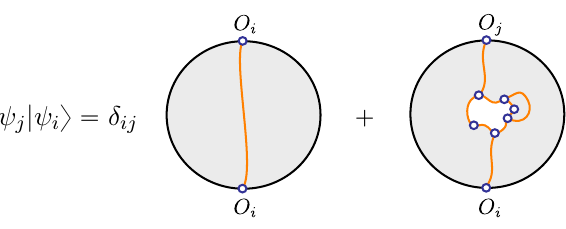
Figure 7 . Picture for (two-sided) matrix elements that generalizes to higher dimensions. One could imagine creating orthogonal states by preparing states with particles of different flavors. In microscopic models the particles could interact heavily in the interior, perhaps close to the singularity, resulting in off-diagonal matrix elements. This conclusion is similar to the effective half-wormholes for eigenvalue correlation in [30, 36] and also to the picture of [12, 13, 35]. Strong interior interactions encode microstructure. This also applies in